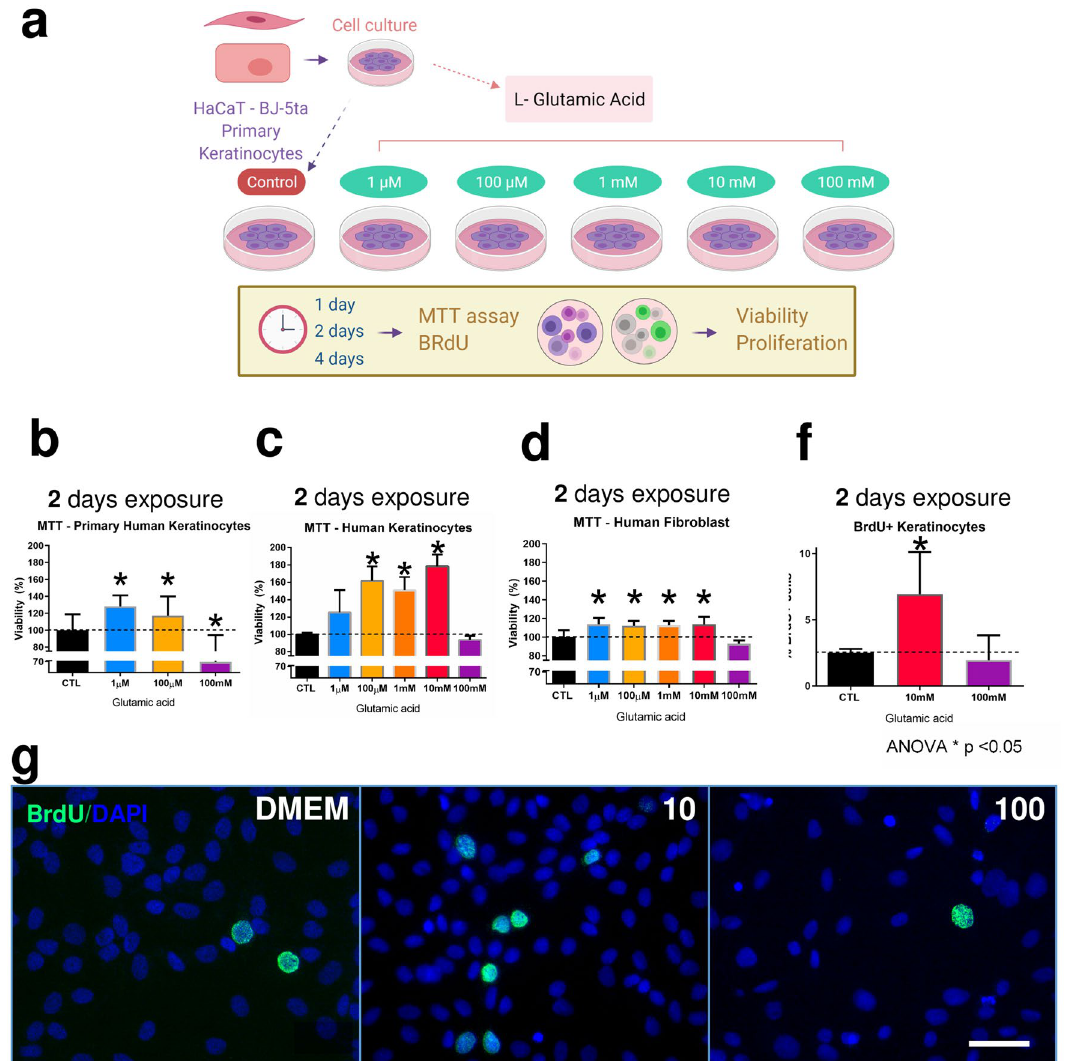
Figure 1. Effects of GA treatment in cell culture and in vivo. Experimental design of cell culture experiment using HaCaT, Primary human keratinocytes, and human fibroblast treated with different concentration of GA ( a ). MTT viability test results of Primary human keratinocytes with 2 days of Glutamic acid exposure ( b ). MTT viability test results of HaCaT with 2 days of Glutamic acid exposure ( c ). MTT viability test results of huma fibroblast with 2 days of Glutamic acid exposure ( d ). MTT viability test of primary keratinocytes in triplicate in 2 different experiments. MTT viability test of HaCaT keratinocytes in quadruplicate in 4 different experiments. MTT viability test of human fibroblast in quadruplicate in 2–3 different experiments. Immunostaining results of HaCaT keratinocytes treated with Glutamic acid 10 mM or 100 mM in DMEM compared to Control group treated with DMEM ( g ). Immunostaining results of HaCaT keratinocytes in triplicate in 4 different experiments, GA for 48 h and, finally, 3 h with BrdU, scale bar 50 μm. The proportion of BrdU-immunoreactive increased after exposure to GA 10 mM ( f ). Data is presented as mean ± SEM. N = 4 per group. p = 0.03 t-test Control versus GA 10 mM; p = 0.03 one-way hair follicle bulge) as the most expressed subunits (Fig. 5d). Additionally, we identified the expression of Excita- tory Amino Acid Transporter 1 and 3 (Slc1a3 and Slc1a1) (Fig. 5e) in 50% of all sebaceous gland cells (Fig. 5e). To predict a GA-mediated cell signalling pathway between GA pathway and hair follicle-related genes, we used computational interaction network analysis STRING 23 . In this way, we used glutamate receptor pathway genes and hair cycle genes ontologies (Supplementary Fig. 2). We found that GA receptors interact with hair cycle genes through the tyrosine-protein kinase Fyn, Ca 2 + /calmodulin-dependent protein kinase II (CaMKII) and protein kinase B ( Akt) (Fig. 5f). Additionally, we found Bcl2 as a common apoptotic regulator between both hair cycle and GA pathways (Fig. 5f). To confirm, we evaluated the protein expression of Fyn, CaMKII and Akt in the 14-day topical GA-treated mice (Fig. 5g–i) . We found no differences in Fyn quantification (Fig. 5i). However, we confirmed that AKT2 phosphorylation increased after 14 days of topical 1% GA treatment (Fig. 5g). Also, pCaMKII increased after 14 days of topical 10% GA treatment (Fig. 5h).